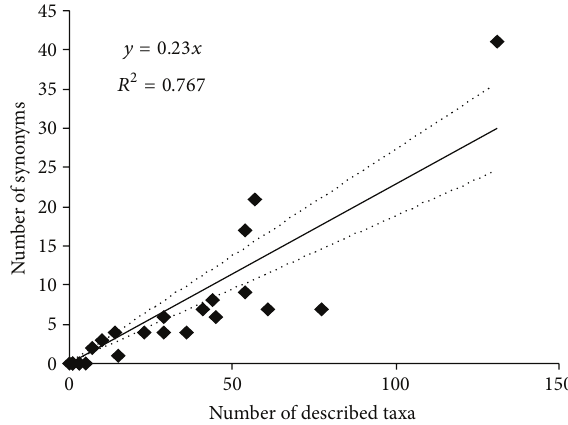
Figure 2: Relationship between number of synonyms and total number of described taxa per decade. Ordinary least square (OLS) regression forced to pass through the